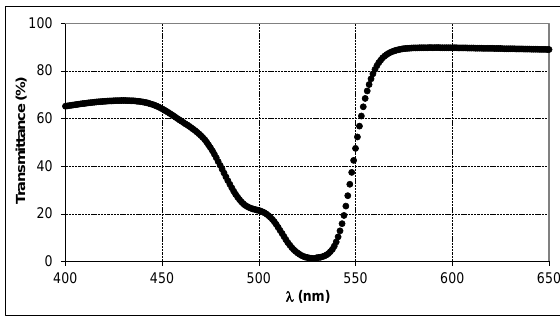
Figure 2. Transmission spectrum of the unexposed photopolymer plate.